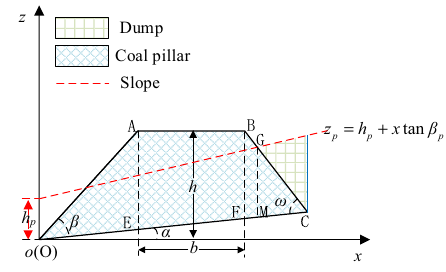
Fig. 6 Development of dumping to coal pillar